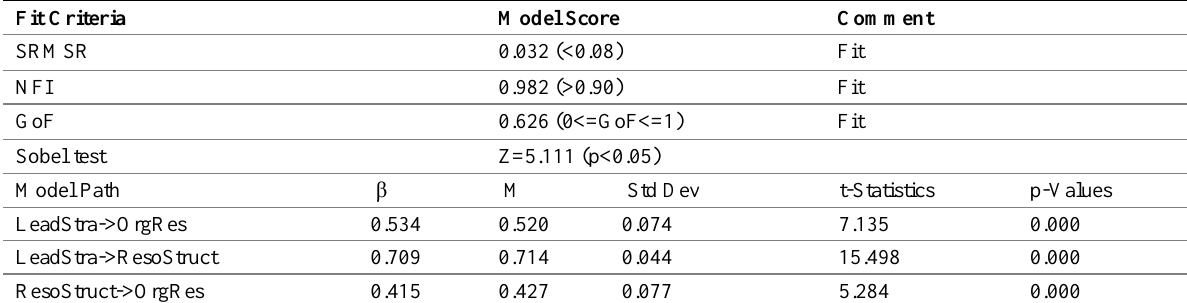
Table 4: Model Fit and Path Coefficients for Resource